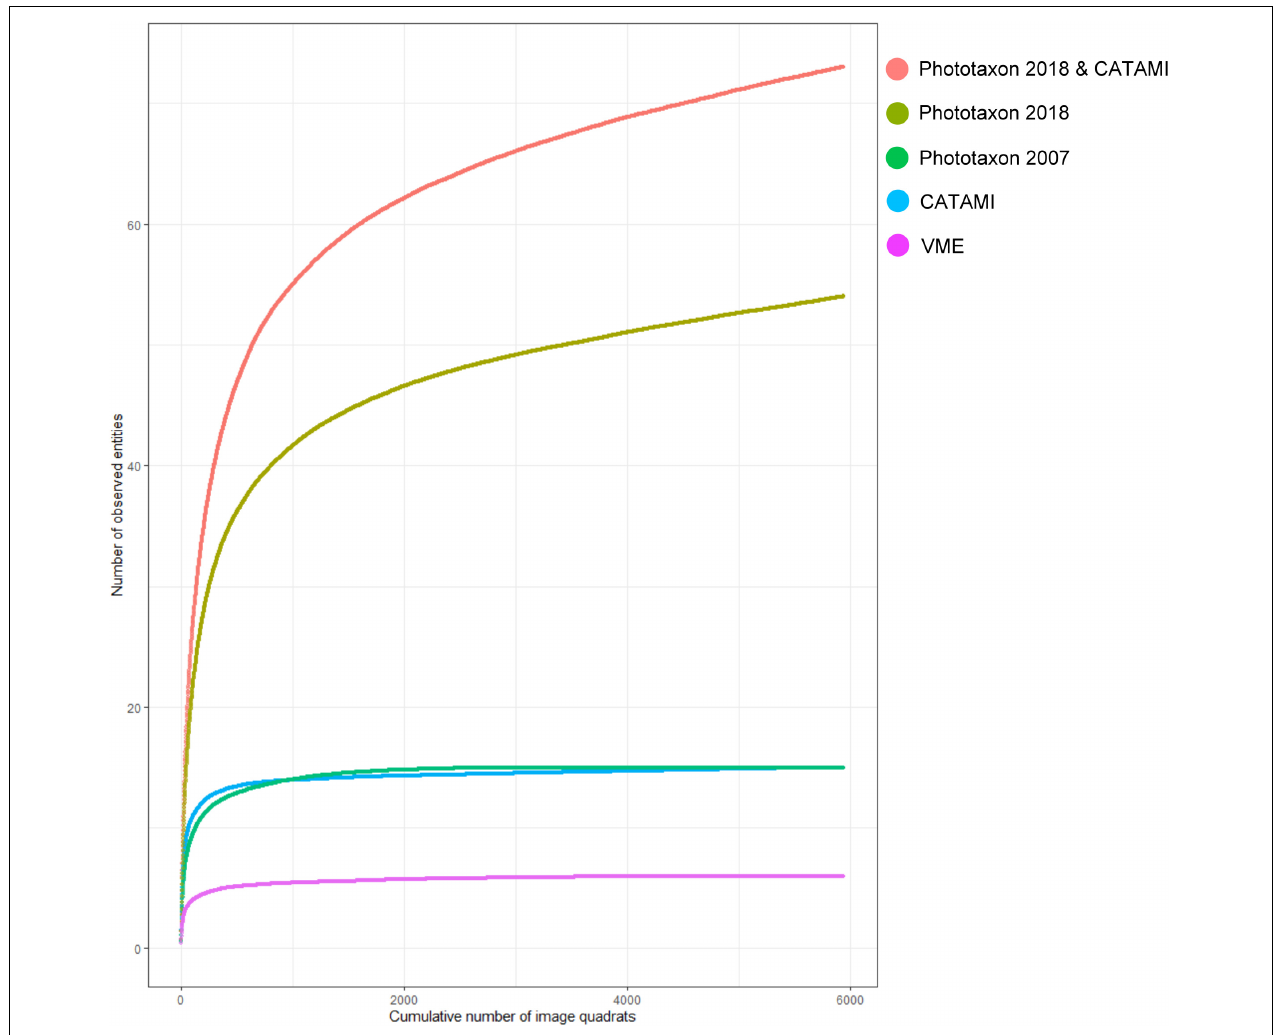
FIGURE 6 | Coral entity accumulation curves calculated for the entire image data set ( n = 5 939 images) for the five classification schemes under consideration. PT_2018, Phototaxa 2018; PT_2007, Phototaxa 2007.